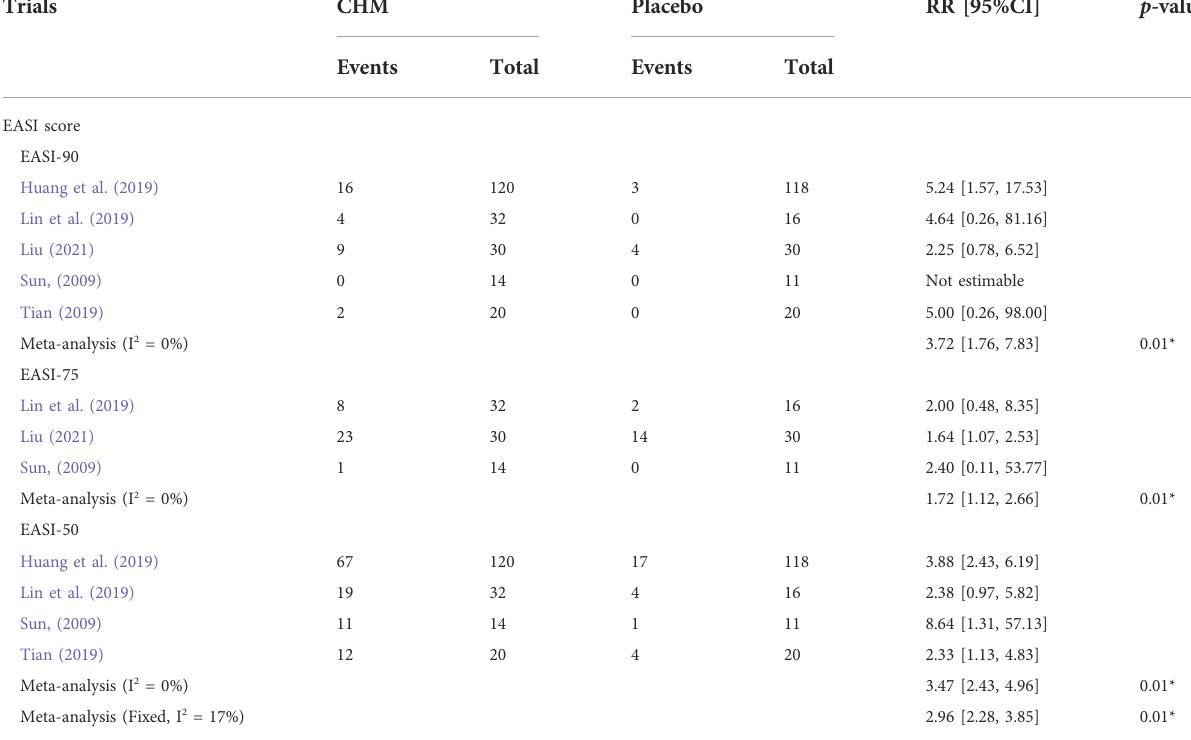
TABLE 2 The primary outcome of ef fi cacy between the CHM and placebo